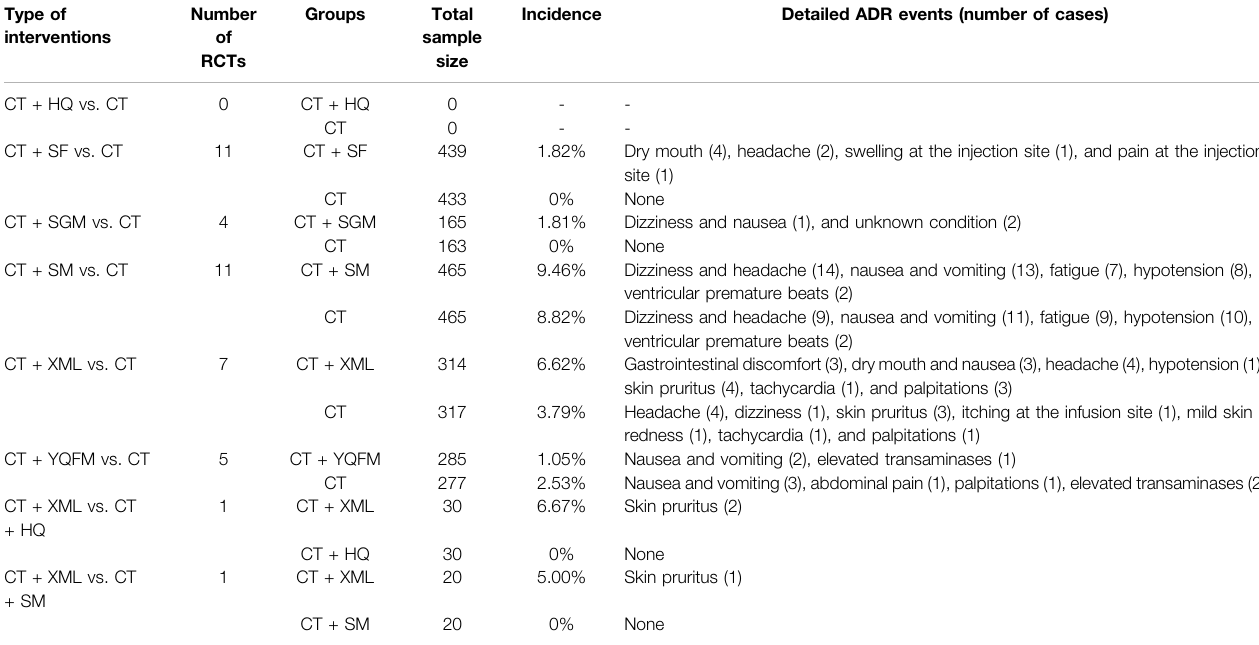
TABLE 4 | Summary of adverse drug events. Type of interventions